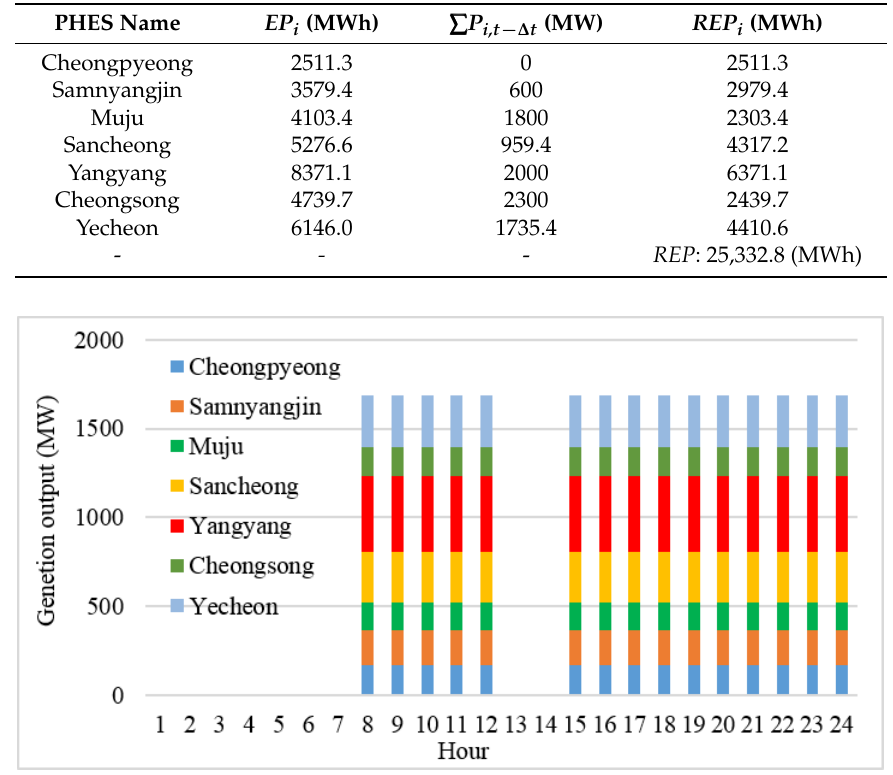
Figure 8. RCP i,t using the uniform allocation method for 2029.